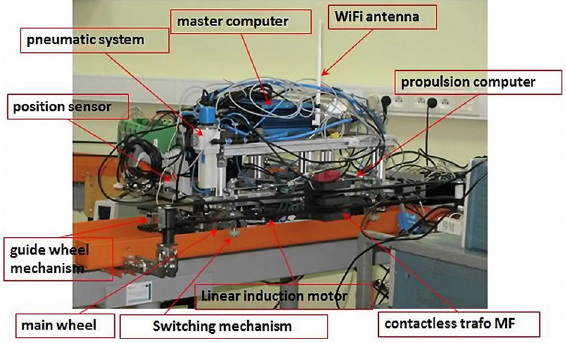
Fig. 2. Physical model of the vehicle on a scale and its systems